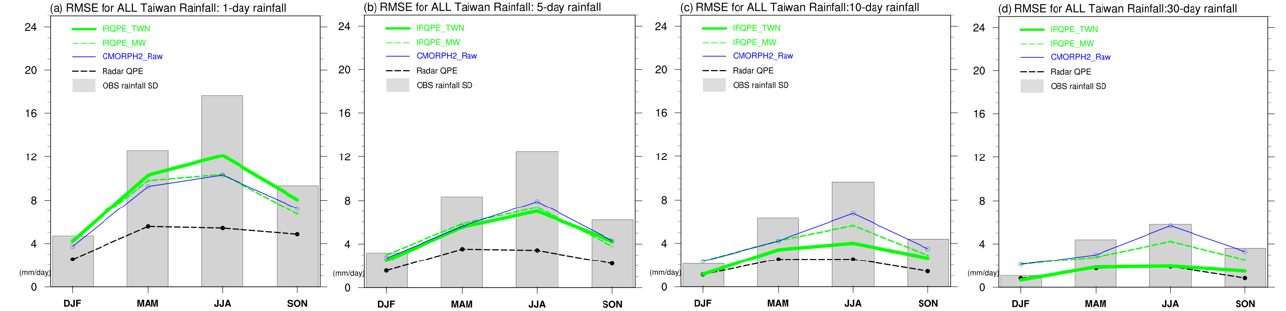
Figure 14. The RMSE derived from comparing with QPESUMS for IRQPE (solid green: IRQPE_TWN, dashed green: IRQPE_MW) and CMORPH2 (blue) for 4-time scale data: ( a ) 1-day, ( b ) 5-day, ( c ) 10-day, ( d ) 30-day. Radar rainfall estimates is also compared (dashed black).